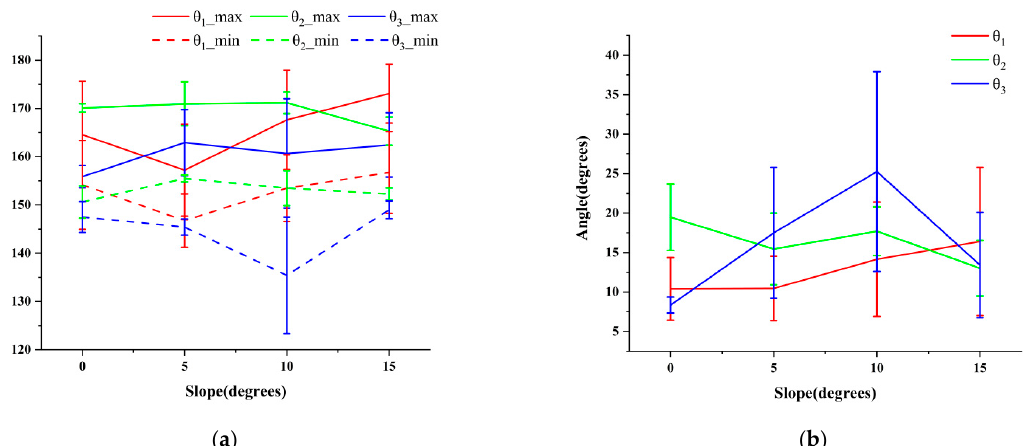
Figure 9. The maximin and variation range of θ 1 , θ 2 , and θ 3 : ( a ) maximum value and minimum value; ( b ) variation range. value; ( b ) variation